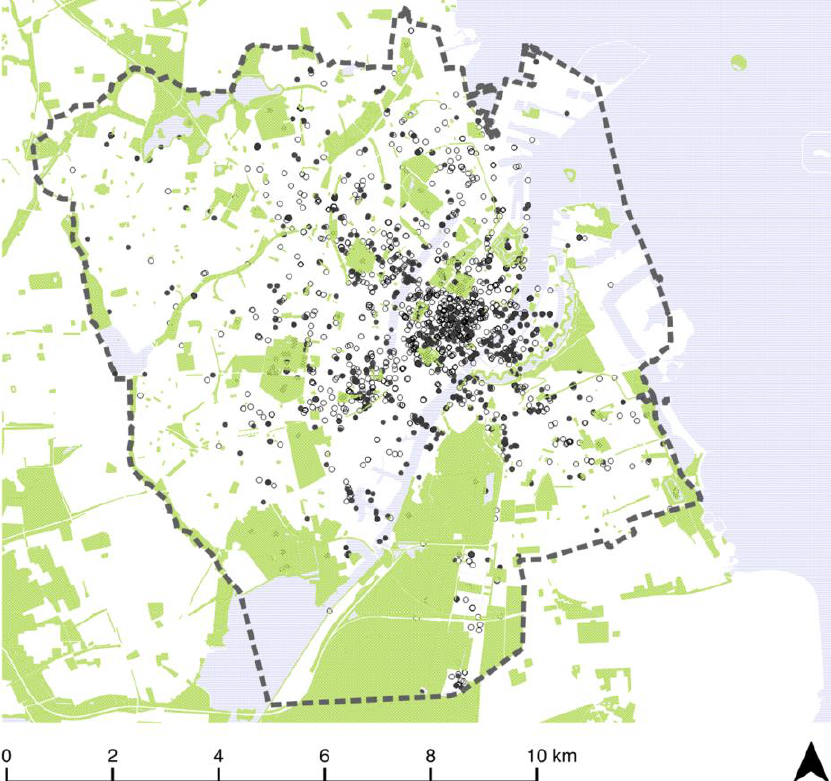
Figure 5. The spatial distribution of Urban Nature (filled symbol) and Not Urban Nature images (outline